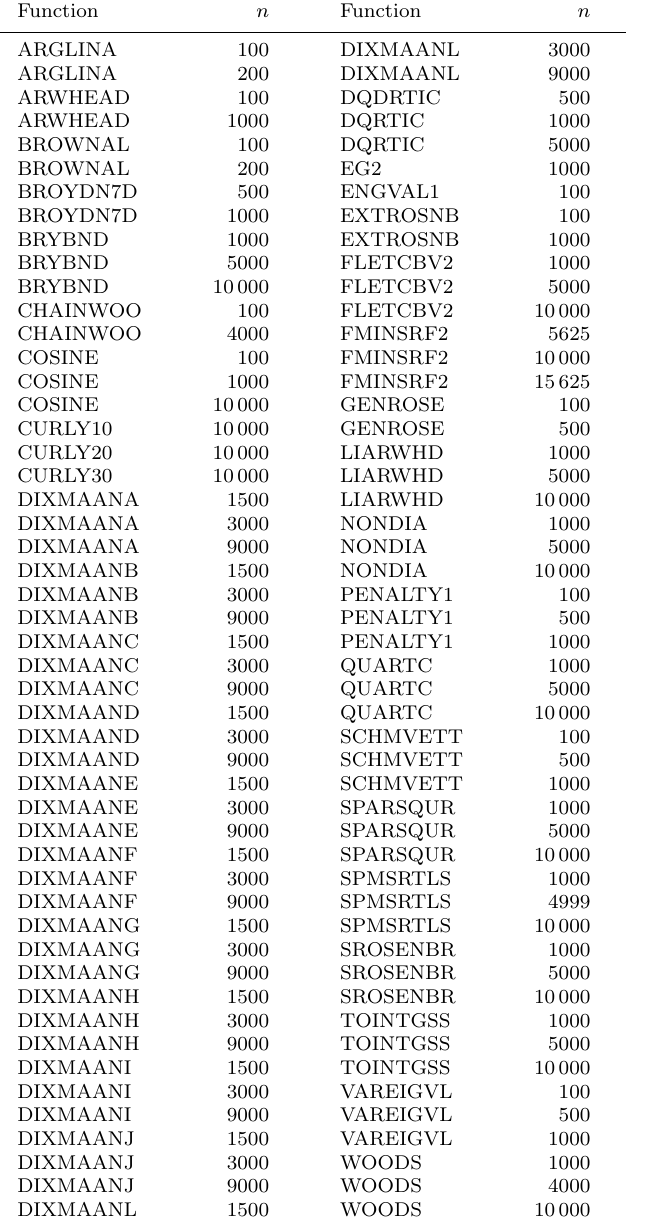
Table 1. The test problems and their dimensions. Function n Function n